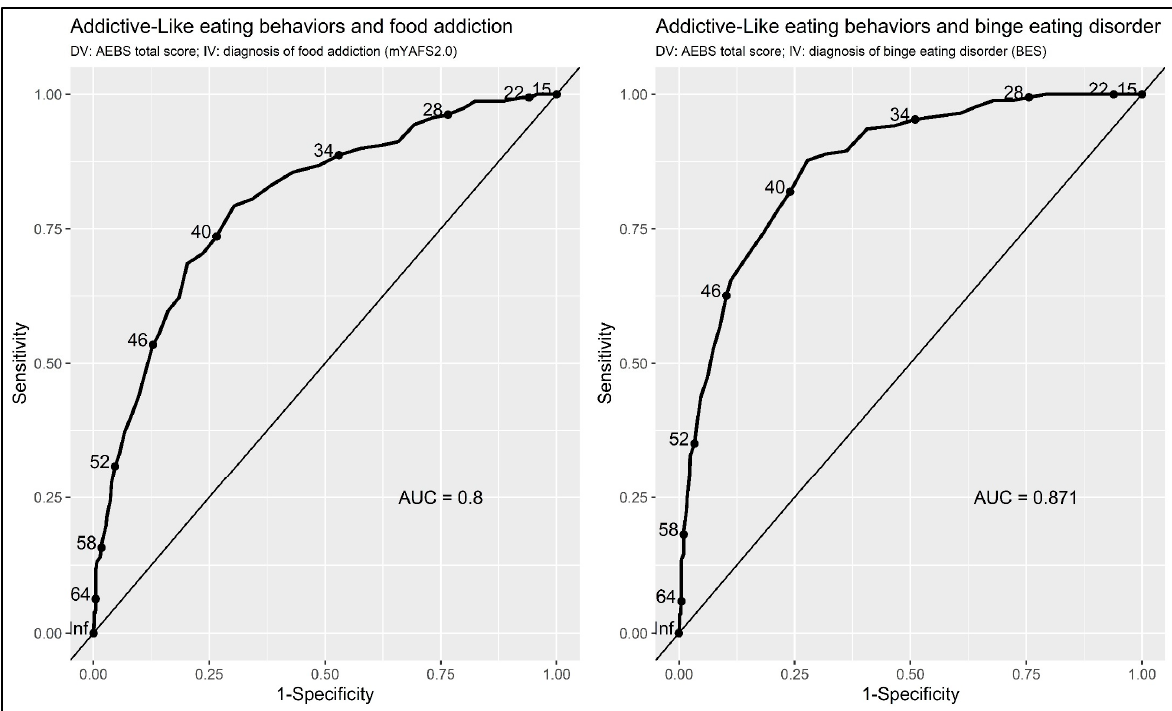
Figure 3. ROC curves.